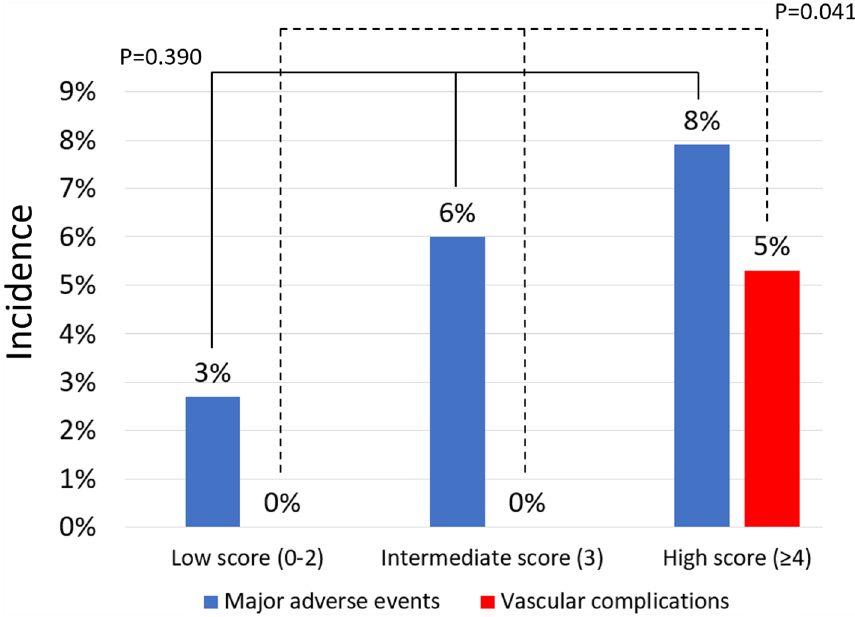
Figure 1. Risk of events according to TAVI-CT (transcatheter aortic valve implantation-computed tomography) score.